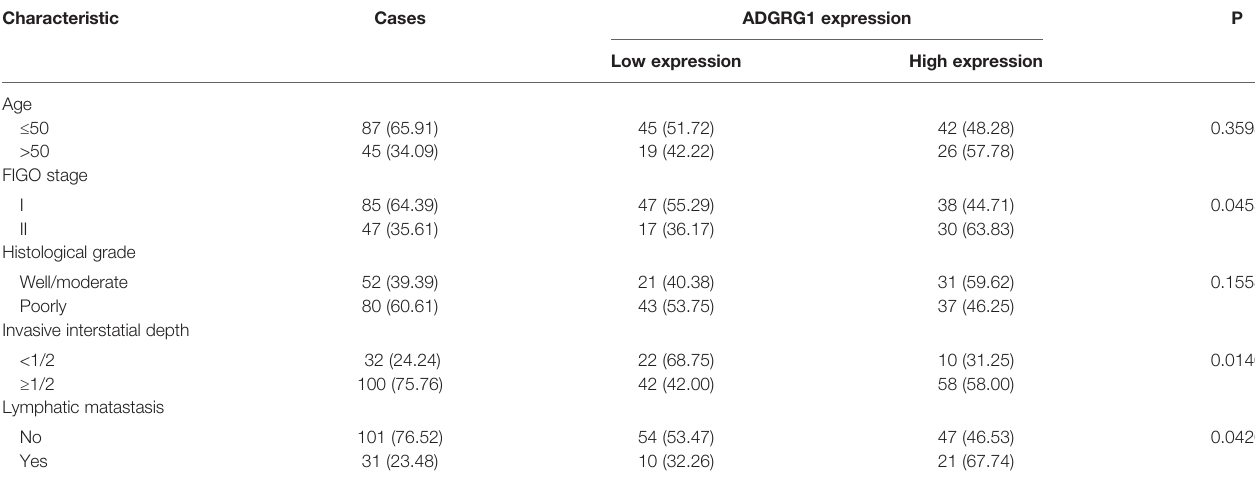
TABLE 1 | Correlations between ADGRG1 expression and clinicopathologic characteristics in cervical cancer. Characteristic